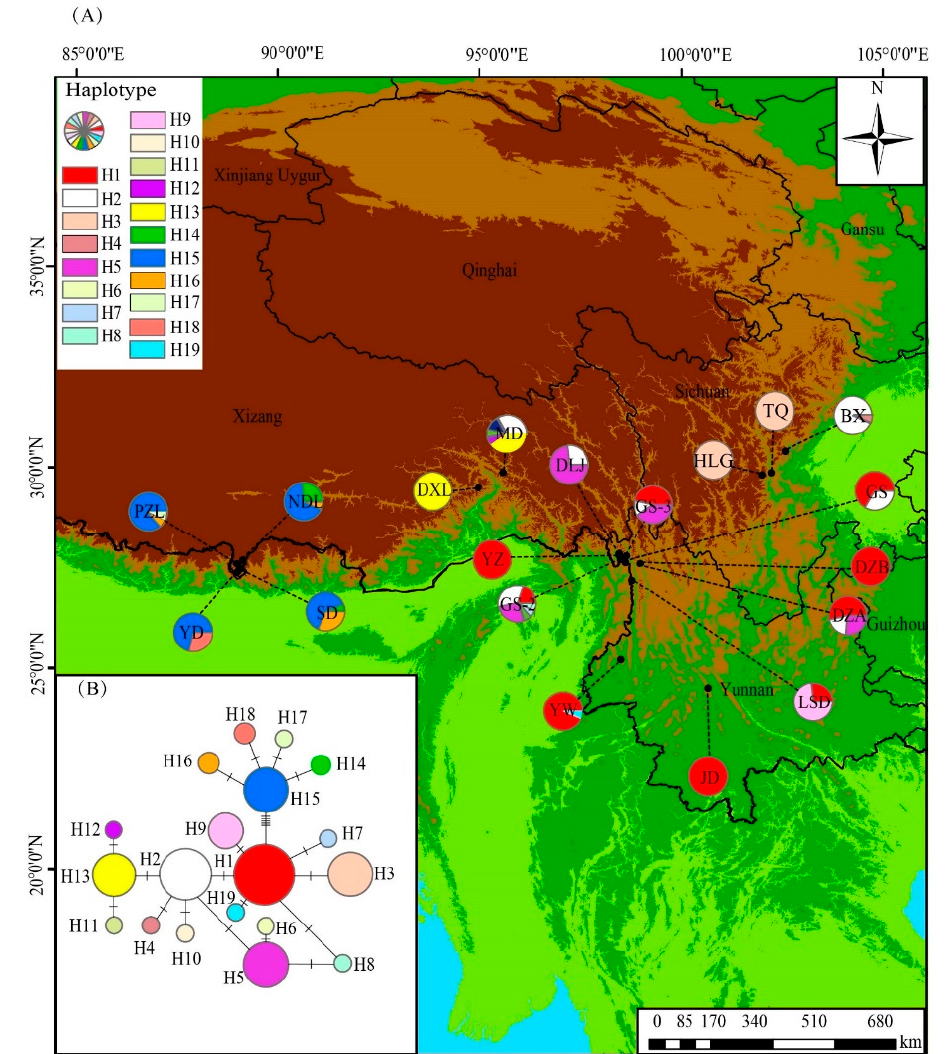
Figure 3. The geographic distribution and network of the 19 cpDNA haplotypes of Gaultheria nummularioides based on the combined data of psb K- psb I and trn V-GAC. ( A ), haplotype geographic distribution; ( B ), haplotype network with frequency denoted by the size of the circle, and each branch representing one mutation.